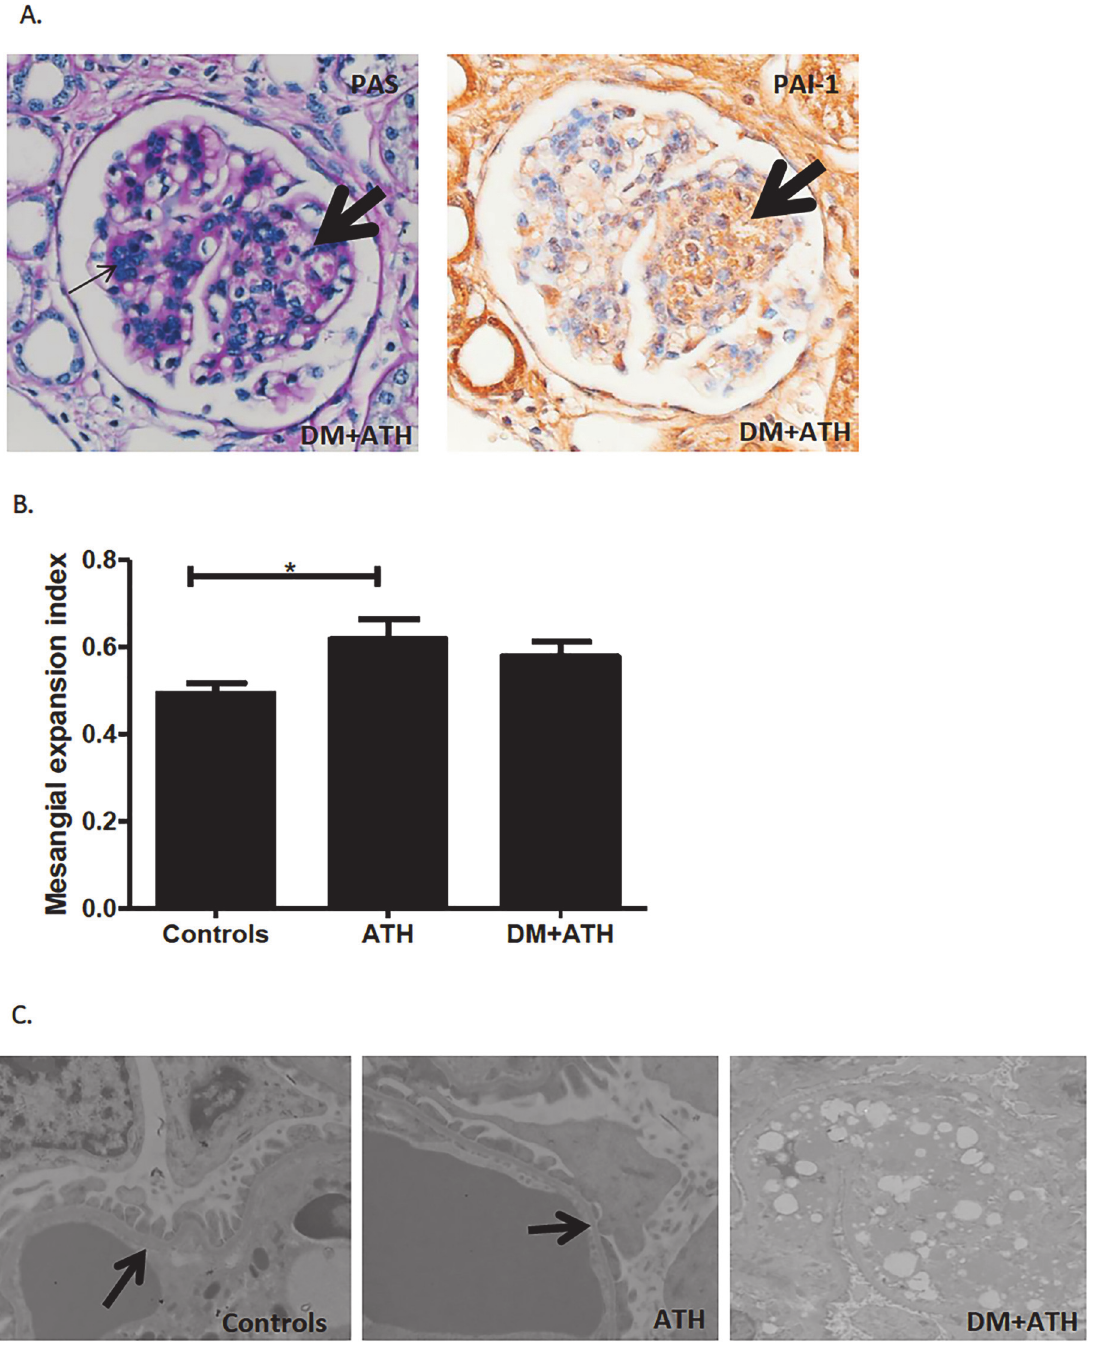
Fig 2. Early stages of atherogenic DM leads to renal damage. A: Representative illustration of PAS stained glomeruli from a DM+ATH pig, showing mesangial proliferation and matrix expansion with capillary loops lying around the mesangium as a corona, reminiscent of a beginning Kimmelstiel-Wilson nodule (left panel; thin black arrow). Dilated capillary loops with red cell fragments show intense PAI-1 staining on consecutive slides (right panel; thick black arrow). B: Mesangial expansion index in Controls (n = 7), ATH (n = 5) and DM+ATH (n = 5) pigs. C. Electron microscopy images illustrating a normal GBM architecture (left panel; thick arrow) of the Controls pig. In ATH, there is slight effacement of the podocyte pedicles (middle panel; thick arrow). In DM+ATH, marked lipid deposits were found (right panel). Data are shown as mean ± SEM. * P < 0.05 compared to Controls or ATH pigs. Original magnification of A: x400 and C: